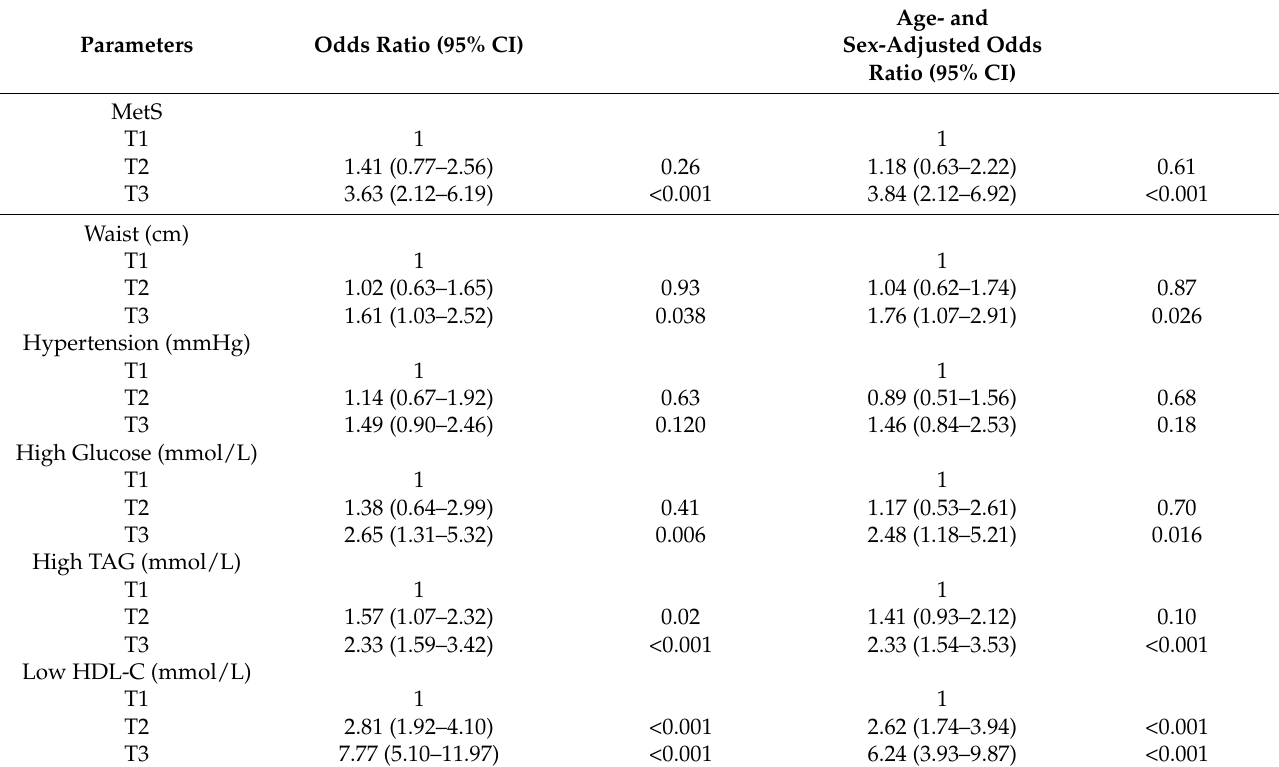
Table 2. Risk factors for MetS and its components according to NOx tertiles.